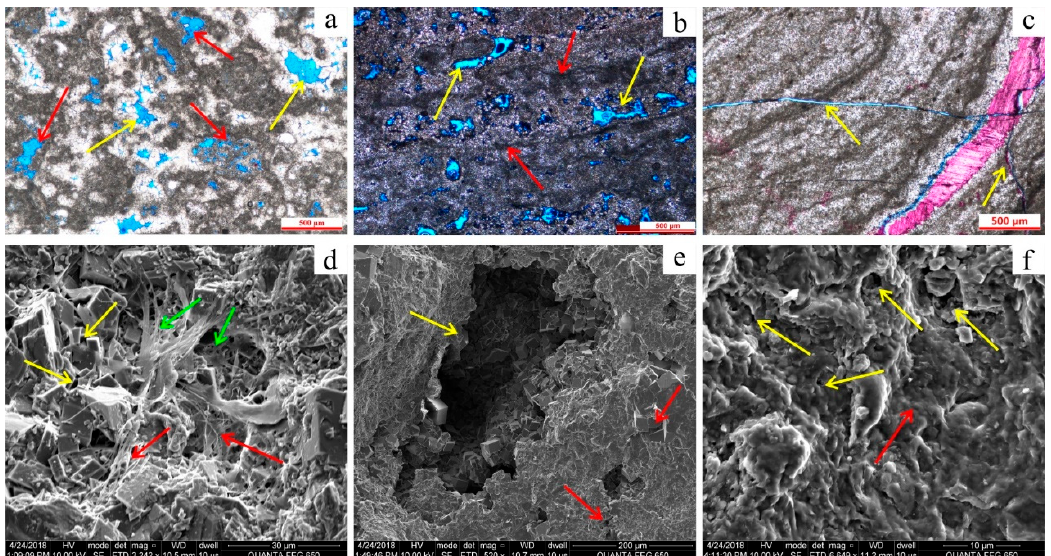
Figure 5. Microscopic characteristics of the pore types in the Leikoupo Formation. ( a ) Inter-clot pores (yellow arrow) and intra-clot pores (red arrow) in thrombolites, T 2 l 43 , Yangshen-1 well, 6228.60 m; ( b ) Fenestral pores (yellow arrow) directionally along the laminations (red arrow) in stromatolites, T 2 l 43 , Yishen-1 well, 5886.80 m; ( c ) Fractures (yellow arrow) in stromatolites, T 2 l 43 , Yashen-1 well, 5788.78 m; ( d ) Inter-crystal micropores (yellow arrow), filiform microbes (red arrow) and micropores in filiform microbes (green arrow) in stromatolites, T 2 l 43 , Yangshen-1 well, 6207.10 m; ( e ) Inter-clot pores (yellow arrow) and inter-crystal pores (red arrow) in thrombolites, T 2 l 43 , Yangshen-1 well, 6228.60 m; ( f ) Inter-particle pores (micropores, yellow) and peloids (red arrow), T 2 l 43 , Longshen-1 well, 5971.46 m.